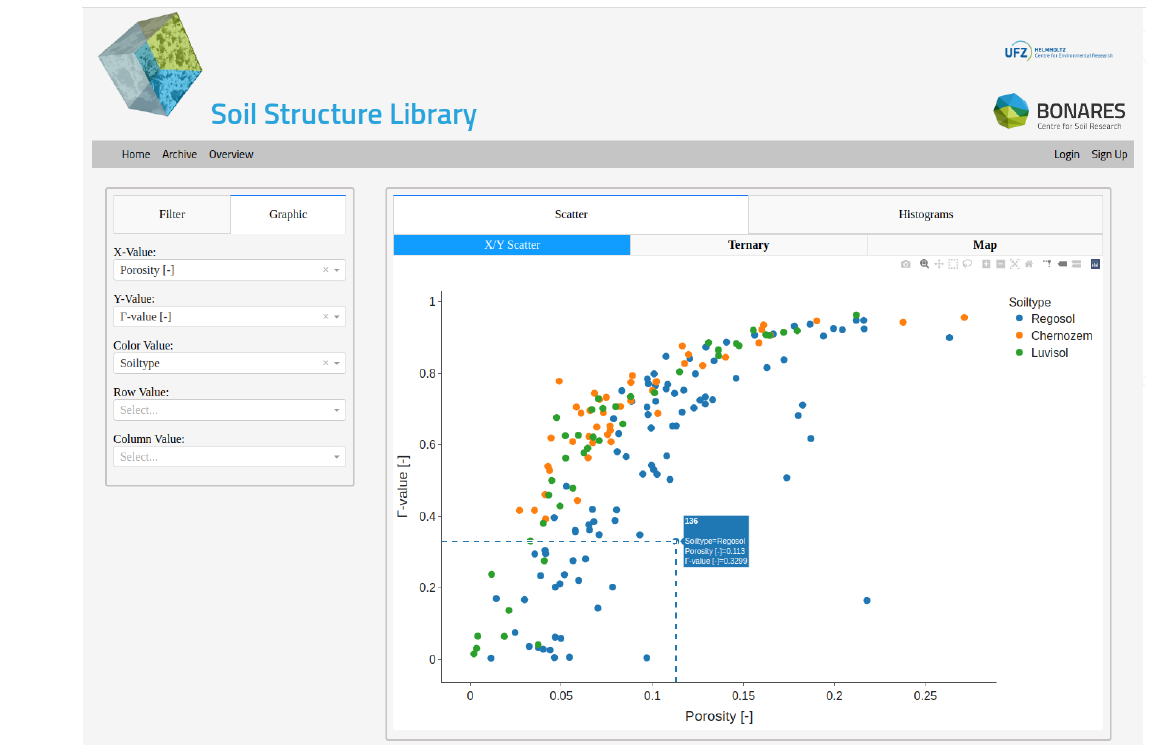
Figure 2. Visualization of the Gamma connectivity as a function of porosity for all data sets. The plotted metrics can be selected under the “Graphic” tab. A subset of data can be plotted by using the filter option to select specific site characteristics. Hovering over the single data points provides more information on the soil type and a direct link to the complete metadata of the selected